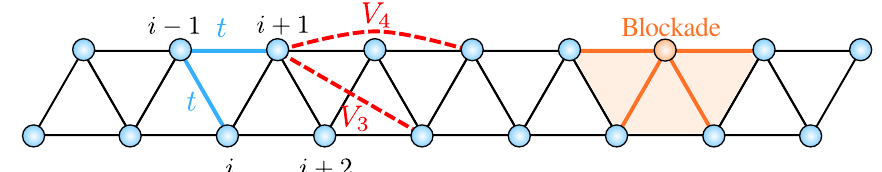
Figure 1: Sketch of the system governed by the Hamiltonian Eq. (4). The hopping t and the interaction terms V respectively. The orange region indicates the radius of the blockade where double occupancy is excluded, n